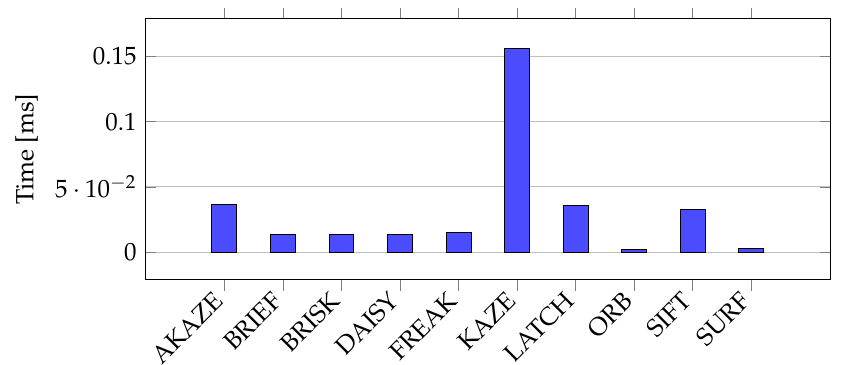
Figure 8. Average time taken to calculate a descriptor for a key point in all images in the Oxford University